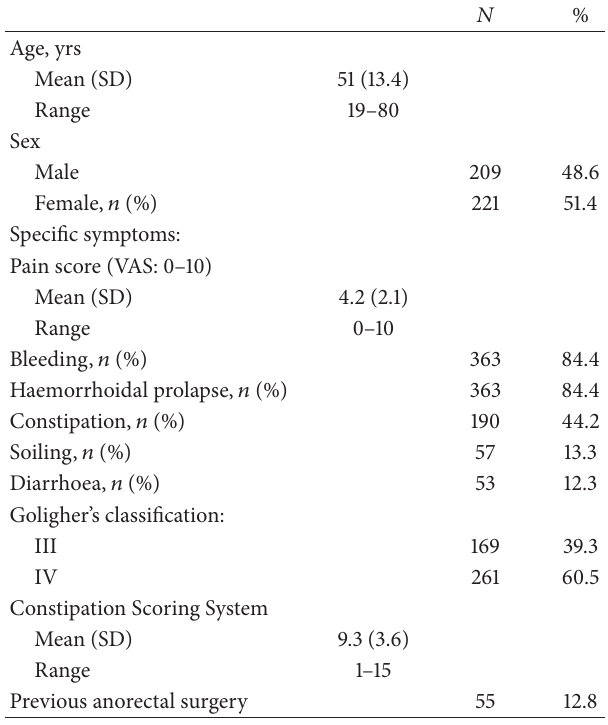
Table 1: Clinical characteristics of patients ( 𝑁 = 430